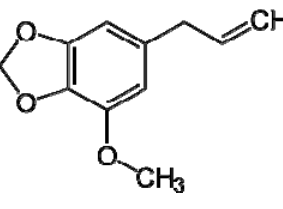
Figure 1. Structural formula of the alkenylbenzene